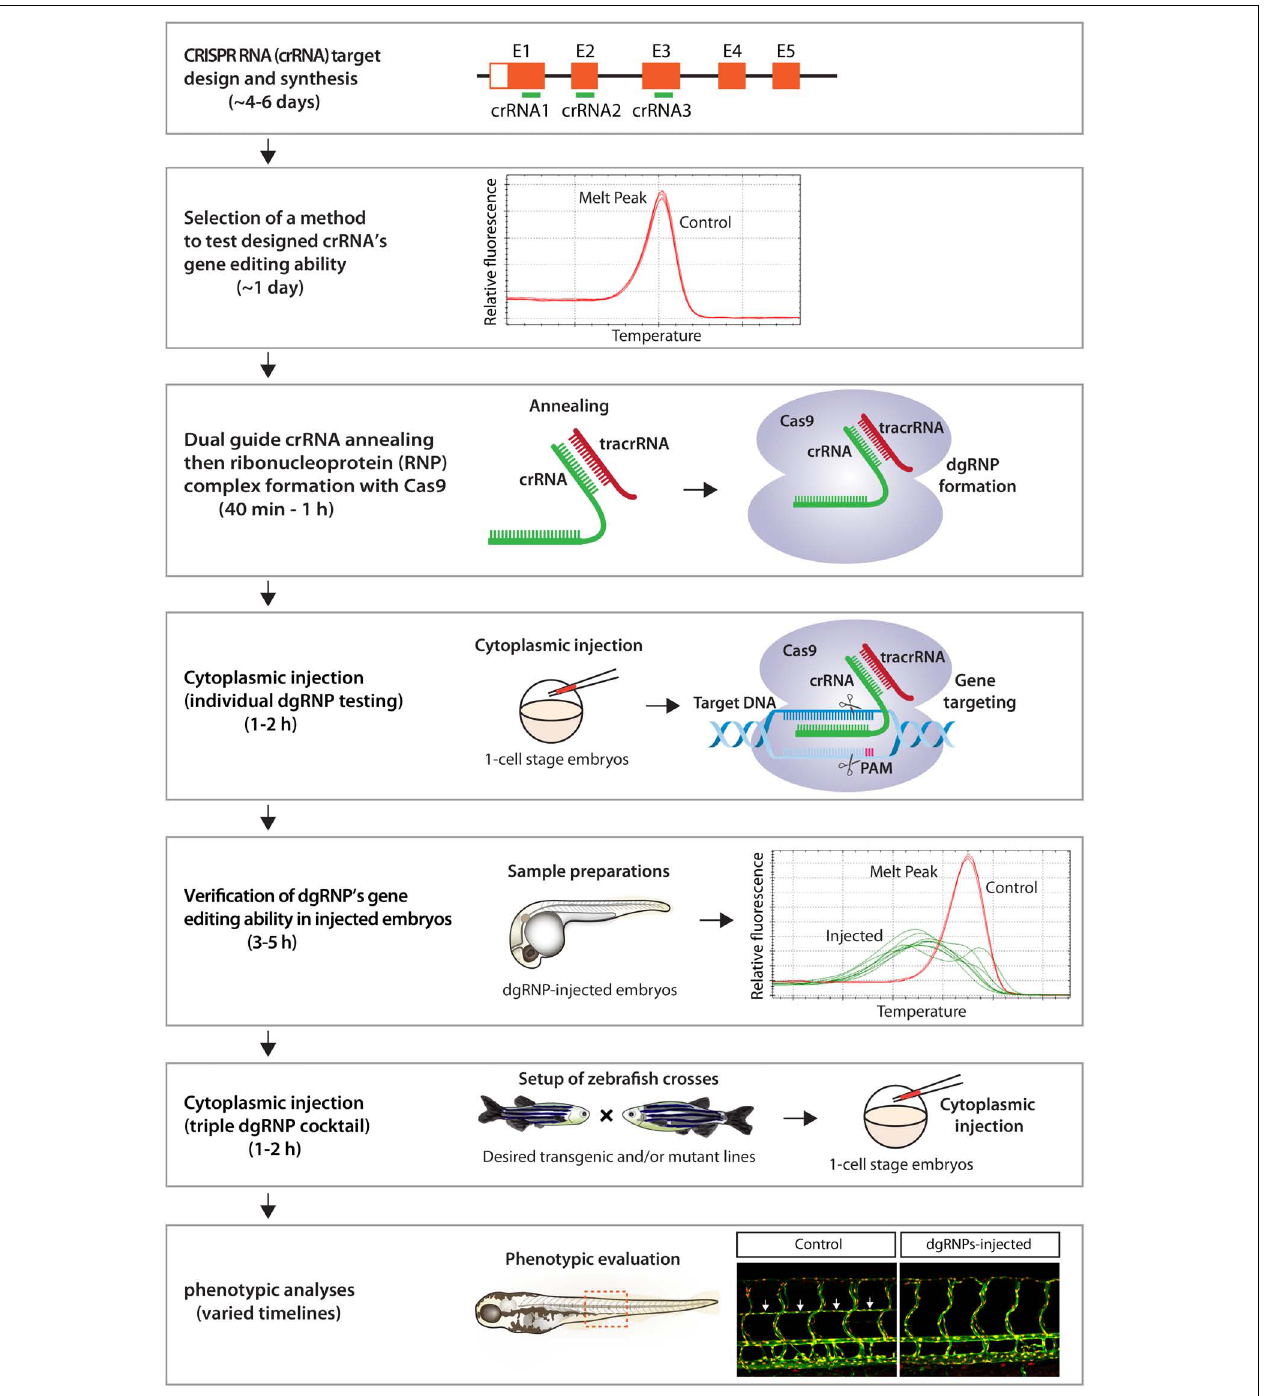
FIGURE 9 | Flowchart summary of triple dgRNP injections for rapid F0 phenotypic screens. This flowchart serves as a quick snapshot of experimental workflow and estimated timelines of the presented method. This method is designed to minimize users’ efforts for crRNA selection, validation, and efficacy testing while maximizing the chance of biallelic disruptions of target genes. Refer to the materials and methods section for detailed methodological descriptions of each step in this flowchart.